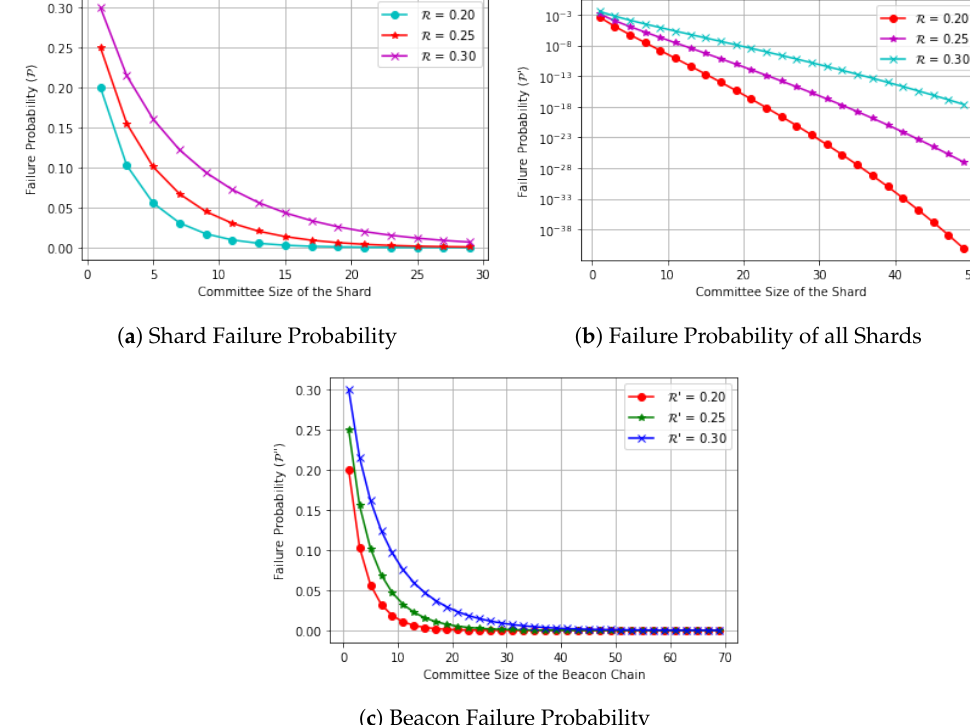
Figure 2. ( a ) Probability of a shard to commit a faulty block ( P ) versus the committee size of the shard ( n ), ( b ) Log-scale plot of the probability of all shards committing a faulty block ( P (cid:48) ) versus the size of the committee ( n ), and ( c ) Probability of the beacon chain to commit a faulty block ( P (cid:48)(cid:48) ) versus the size committee of the beacon chain ( n (cid:48)